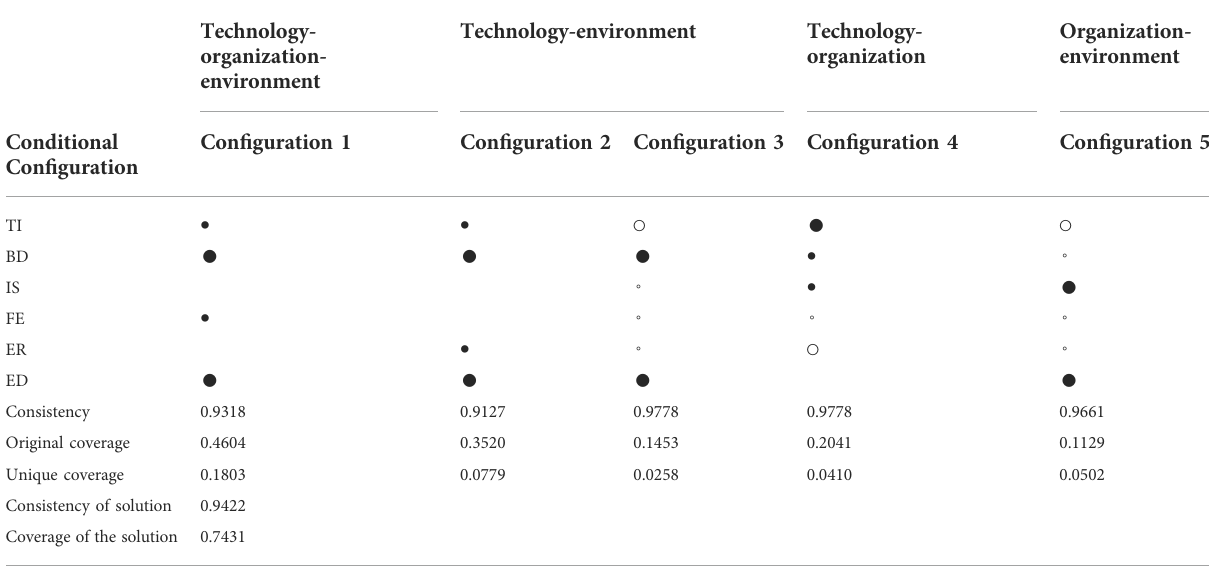
TABLE 4 Analysis of high-level circular economy performance con fi